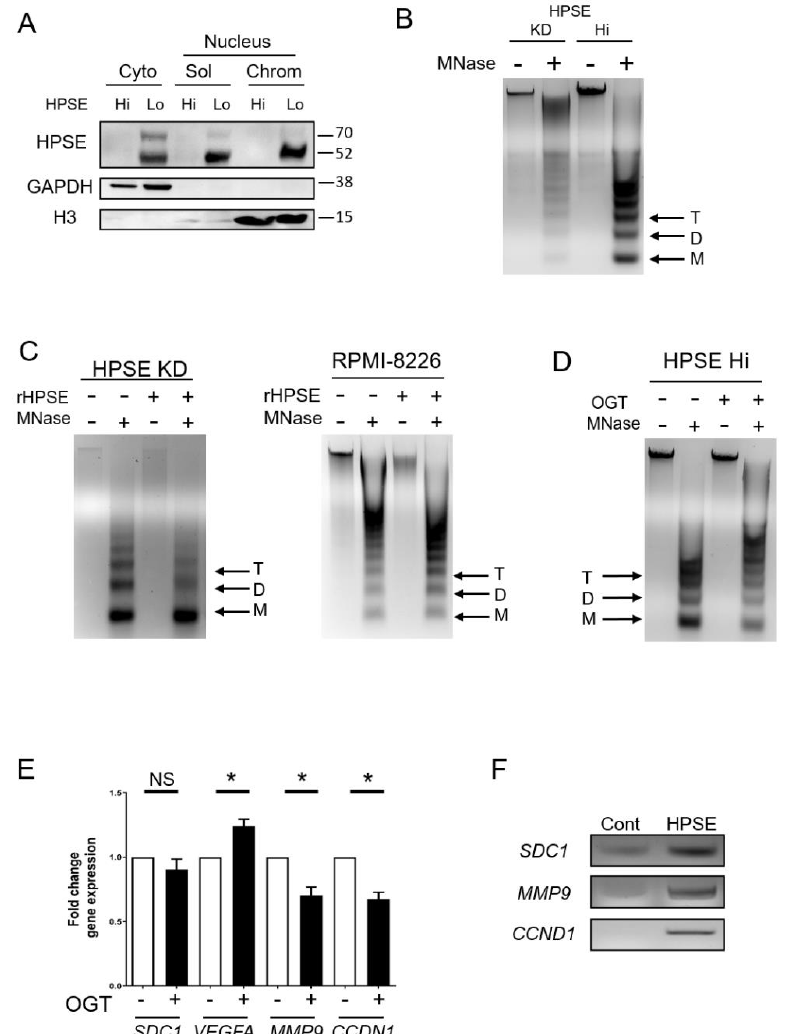
Figure 1. Heparanase enhances chromatin accessibility. ( A ) To determine localization of heparanase, sequential cell fractionation of myeloma cells was used to isolate cytoplasmic (cyto), nucleus-soluble (sol), and nucleus-chromatin (chrom) fractions from CAG wild-type (HPSE Lo) and transfected CAG HPSE Hi cells prior to Western blot analysis. GAPDH and histone H3 (H3) were probed to assess the quality of the fractions. ( B) Chromatin accessibility in CAG HPSE knockdown (KD) and HPSE Hi cells were assessed by sensitivity to micrococcal nuclease (MNase) digestion. Nuclei from KD and HPSE Hi cells were prepared and digested with 0.1 U/μL MNase and subjected to electrophoresis. Black arrows denote Tri (T), Di (D) and Mono (M)—nucleosomes. ( C) Nuclei from CAG HPSE KD and RPMI-8226 myeloma cells were treated for 2 h with or without rHPSE before being subjected to Mnase digestion for chromatin accessibility. ( D ) CAG HPSE Hi cells were incubated with 20 µM of the HPSE inhibitor OGT2115 and chromatin accessibility was assessed following exposure of nuclei to MNase. ( E ) mRNA expression analysis by RT-PCR of syndecan-1 ( SDC1 ), vascular endothelial growth factor A ( VEGFA ), matrix metalloproteinase-9 ( MMP9 ) and cyclin D1 ( CCDN1 ) in CAG HPSE Hi cells in the presence or absence of OGT2115, compared to respective control. * p < 0.05 by one-tailed, paired t - test. ( F ) Chromatin immunoprecipitation assay was performed on CAG HPSE Hi cells to analyze HPSE binding to the promoter regions of SDC1 , MMP9 and CCND1 . PCR was performed using primers probing the promoter regions of indicated genes after pulldown with an antibody control (Cont) or anti-heparanase (HPSE) and result was assessed by gel electrophoresis.